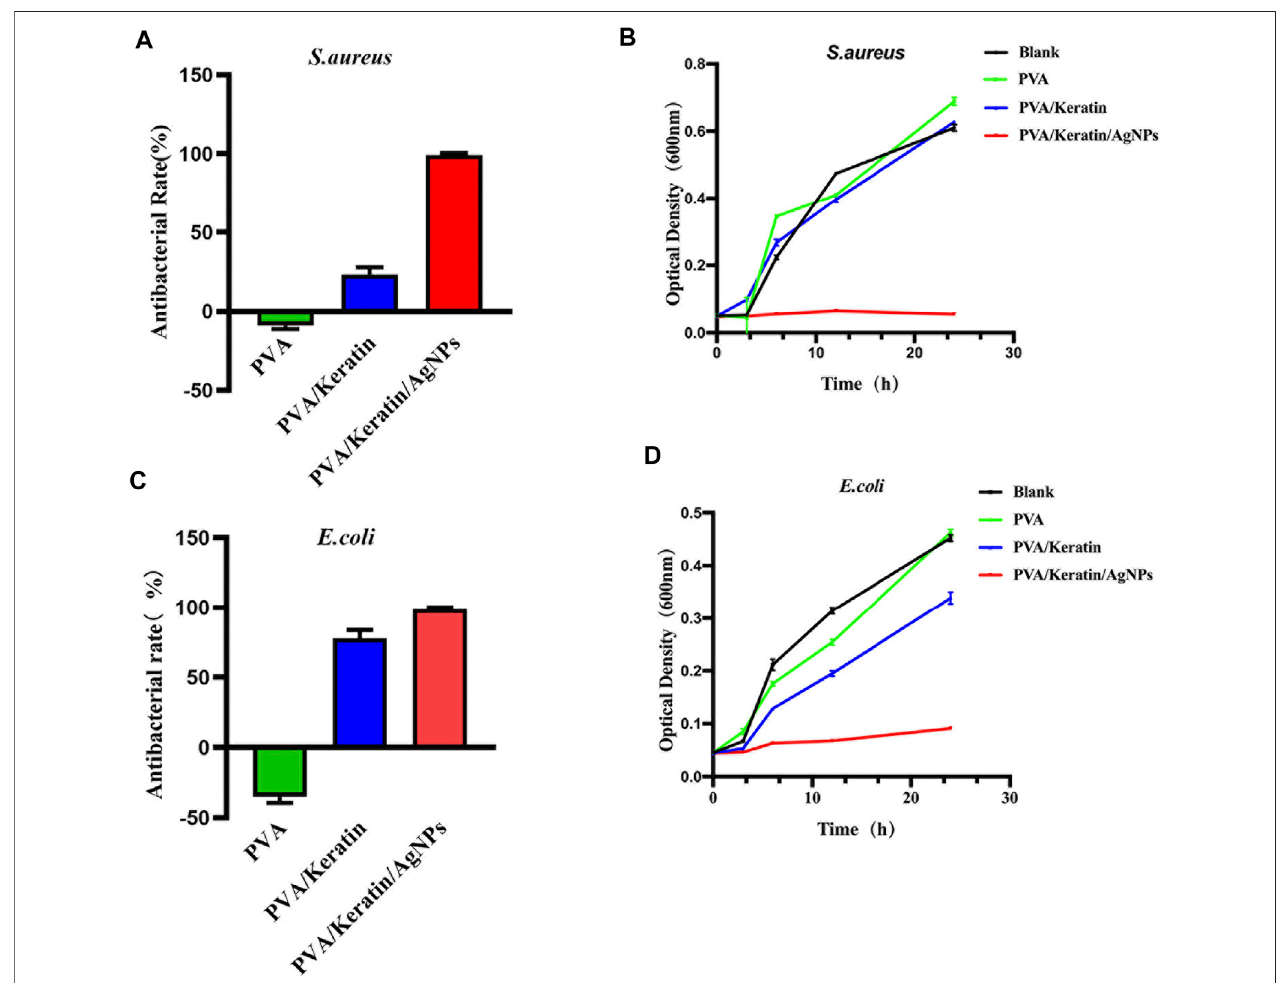
FIGURE6| Antibacterialrateandbacterialkineticsof S.aureus and E.Coliinvitro . (A,C) Antibacterialrateofdifferentmaterialsagainst S.aureus and E.Coli . (B,D) Bacterial kinetics of S. aureus and E. Coli on different materials.